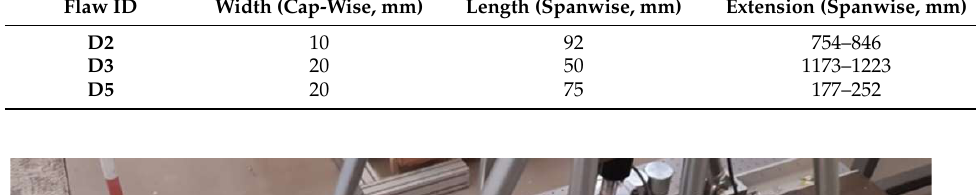
Figure 34. An overview of the experimental set-up: acquisition PC, optical interrogator, optical ta- ble, test rig, test article. The nominal symmetrical load was slightly shifted from the center line between the two supports so that it did not interfere with the damage D2. The test rig had tools that allowed us to apply different kinds of load on the beam, ranging from a nominal concen- trated load (applied along few mm of the beam spam to several centimeters), which per- mitted us to verify possible effects of the load type on the evidence of the damage effects. Such a configuration was applied for both the symmetrical and non-symmetrical load. Therefore, 0, 50, 88, and 190 mm distributed loads were applied, 0 indicating a nominal concentrated force. The original FEM model was then adjusted to consider the damage presence (Figure 35). In particular, a finer mesh, 1 mm step vs. the original 8 mm step, was realized in the regions where the faults were present. In order to avoid increasing the complexity of the model too much, such refinement was limited to an extension equal to 5 times the length of the considered fault. The strain values from a row of nodes positioned at the cap inter- face with the bonding layer were extracted from the FEM analysis and directly compared